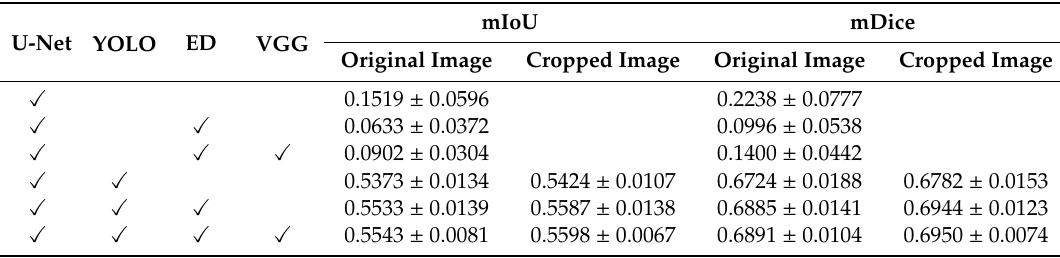
Figure 4. Representative examples of the ventricular septum segmentation in test data for each module combination. One horizontal row presents the segmentation results obtained using each method for the same case. The white pixels are estimated as the ventricular septum, and the degree of whiteness indicates the confidence level. Among the various module combinations, the segmentation results of U-net + YOLO (You Look Only Once) + ED + VGG (CSC) were most in accordance with the ground truth. The YOLO significantly contributed to the improvement of the segmentation accuracy, and ED improved the segmentation. Moreover, the addition of VGG slightly narrowed the prediction section. Table 3. Evaluation of segmentation results for each combination of modules with respect to the mIoU and